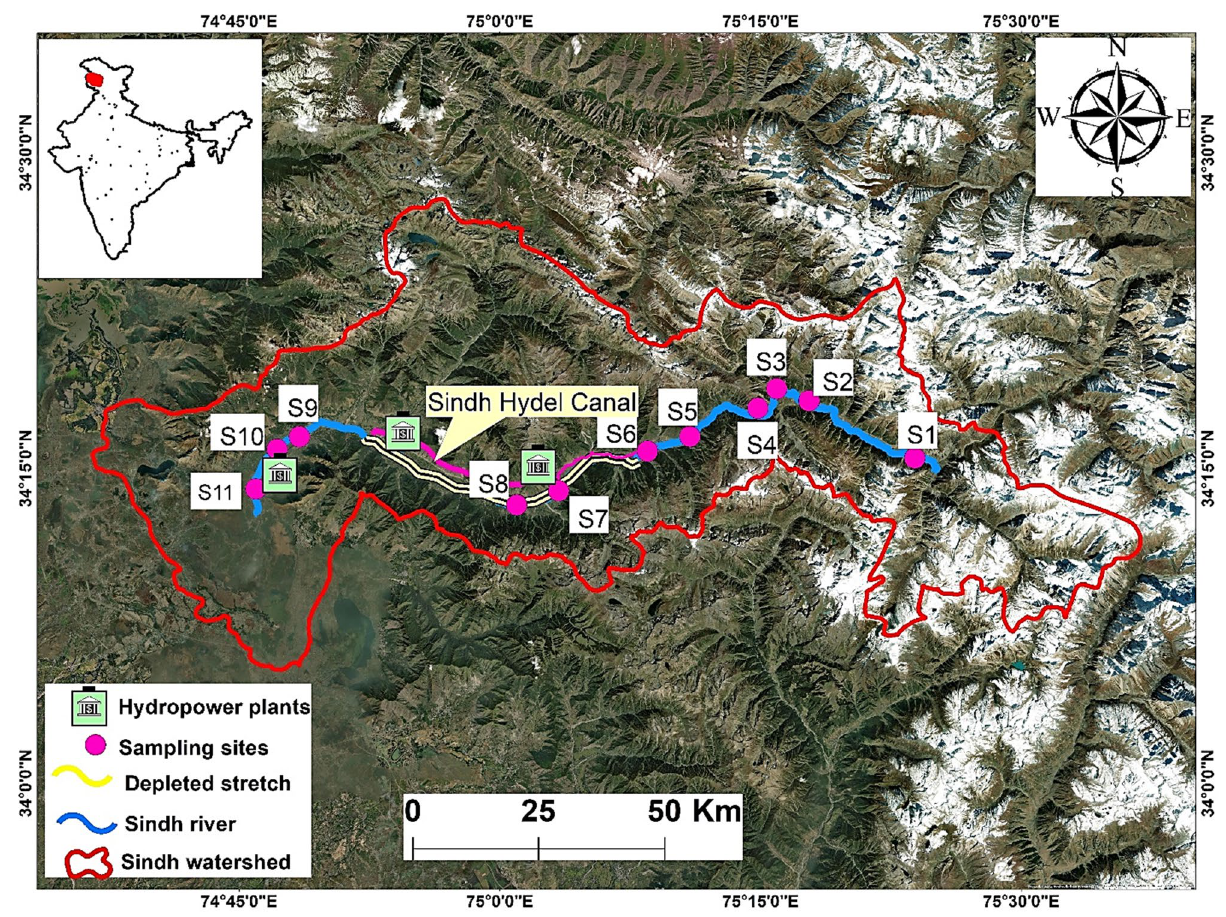
Figure 1. Study area showing the eleven sampling sites along the River